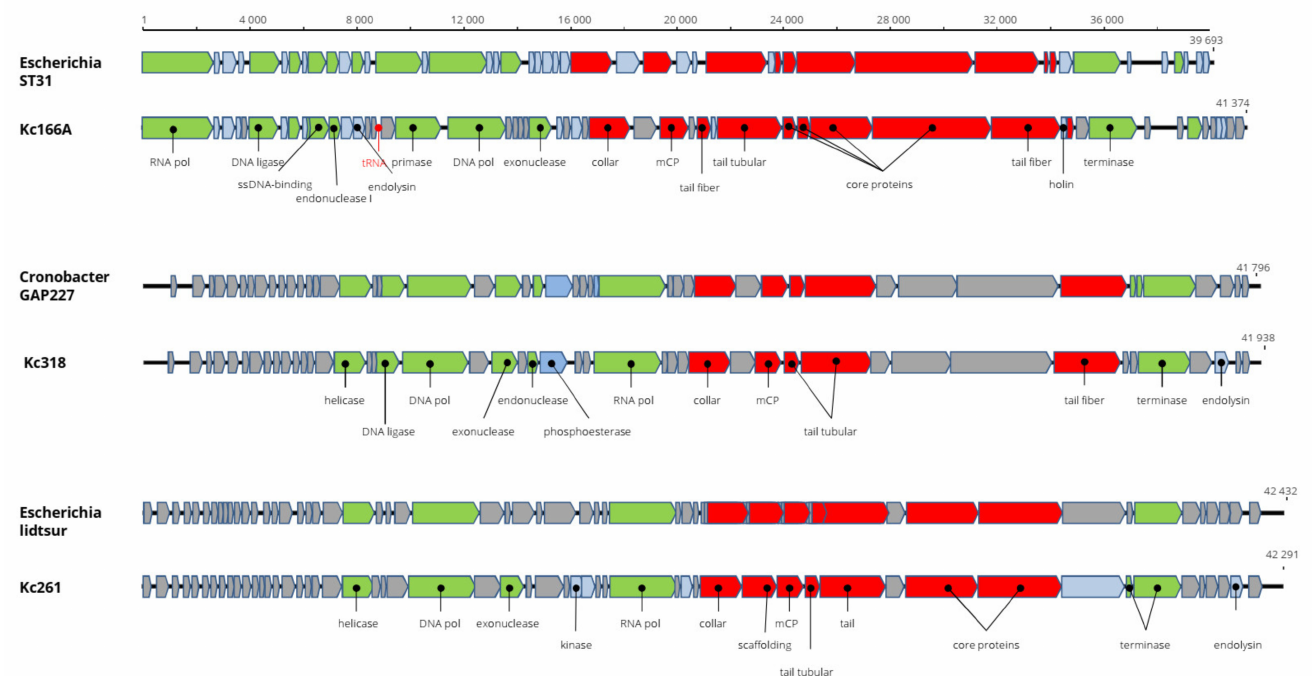
Figure 3. Genome organization of Kc166A, Kc318, and Kc261 in comparison with the closely related viruses. Here and in the next figures, the structural proteins are marked red, replication-associated proteins are light green, phage metabolism proteins are blue, proteins with regulatory functions are marked violet, hypothetical proteins with unknown functions are gray, and positions of tRNAs are marked red. All genes are drawn to